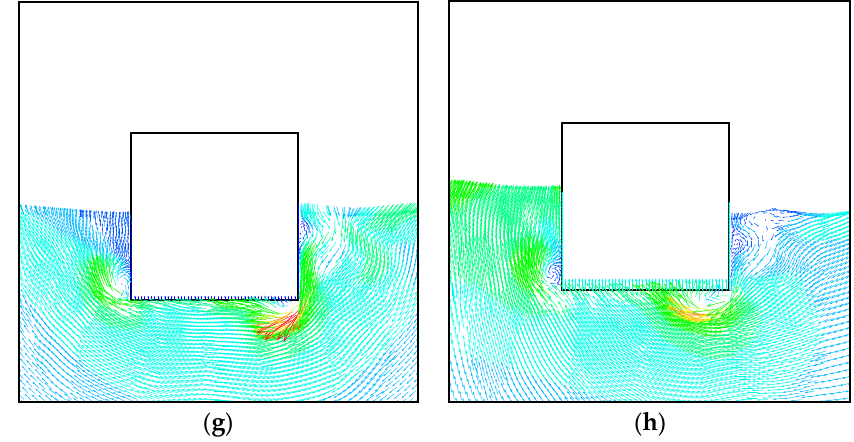
Figure 10. Flow fields around the buoy in a wave cycle ( H = 0.1 m, T = 1.75 s). ( a ) t = T/8; ( b ) t = 2T/8; ( c ) t = 3T/8; ( d ) t = 4T/8; ( e ) t = 5T/8; ( f ) t = 6T/8; ( g ) t = 7T/8; ( h ) t = 8T/8.